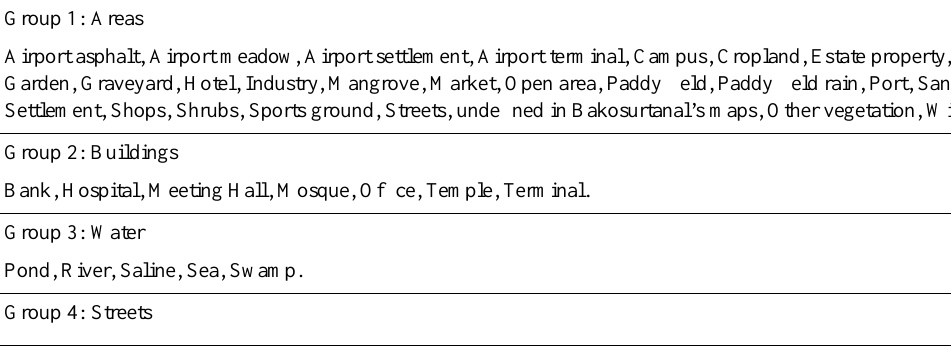
Table 2. Land use classification of Kuta, Bali.